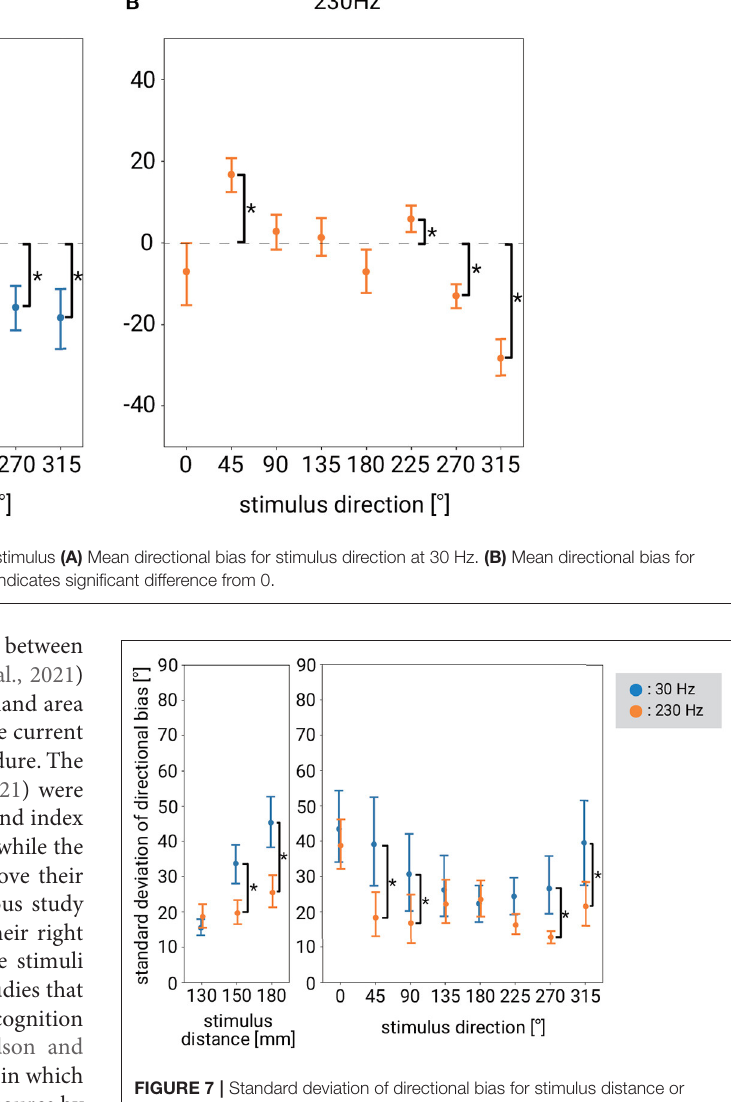
FIGURE 7 | Standard deviation of directional bias for stimulus distance or stimulus direction at 30 and 230 Hz. Error bars denote 95%CI. The asterisk indicates significant difference between stimulus